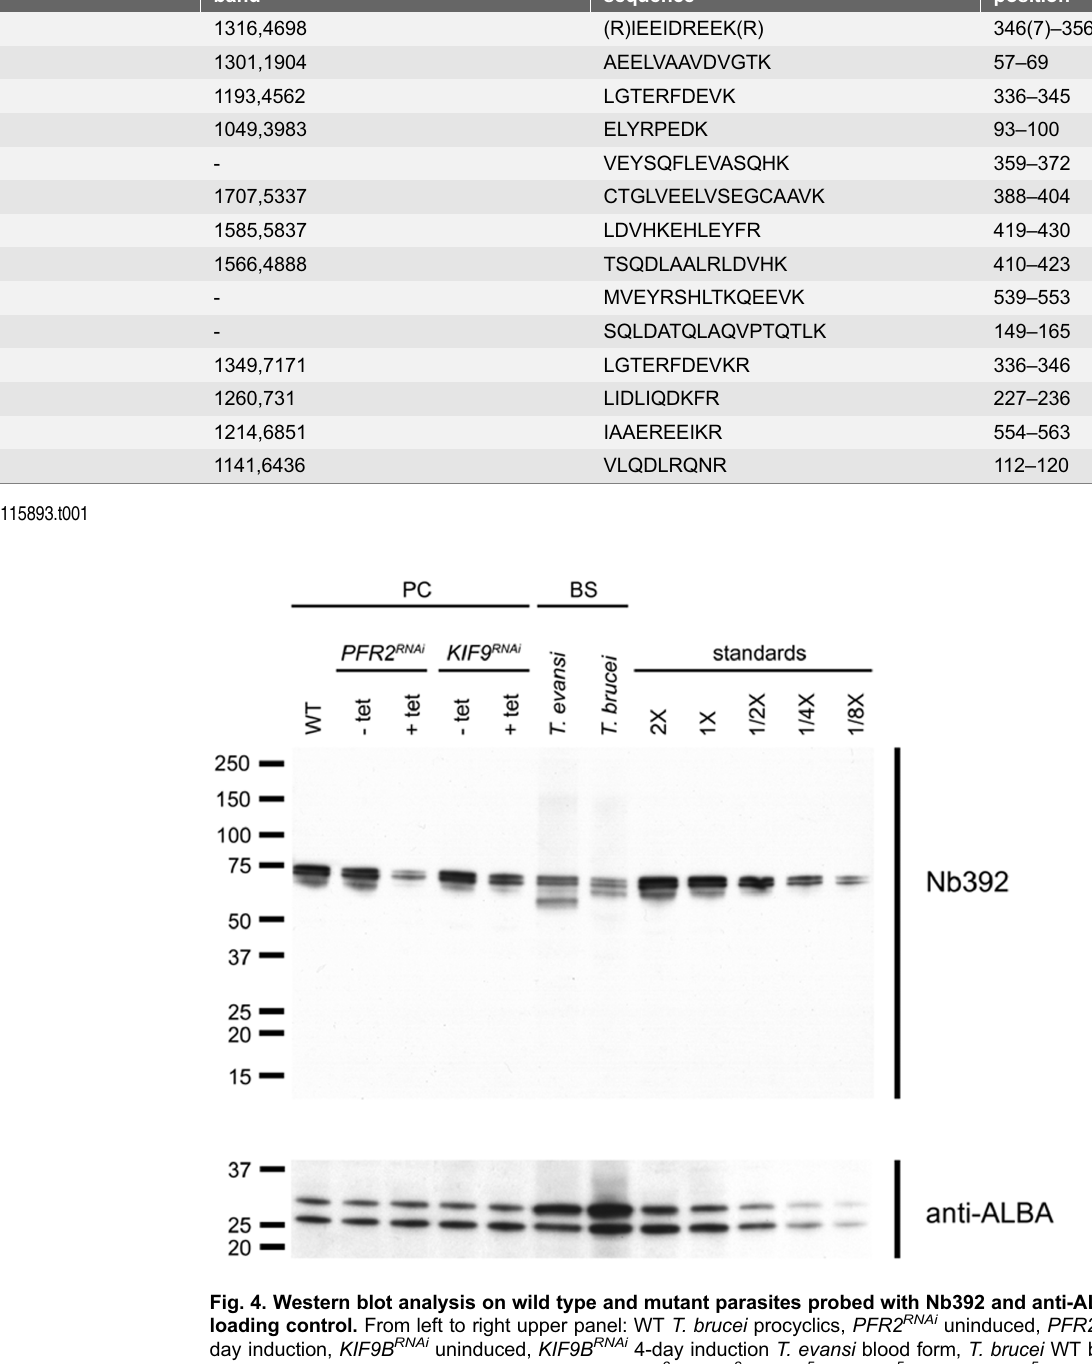
Table 1. List of peptide masses from mass spectra of upper and lower bands and their respective sequence matches with the positions in the genome of T. brucei . Peptide masses (Da) in upper protein band